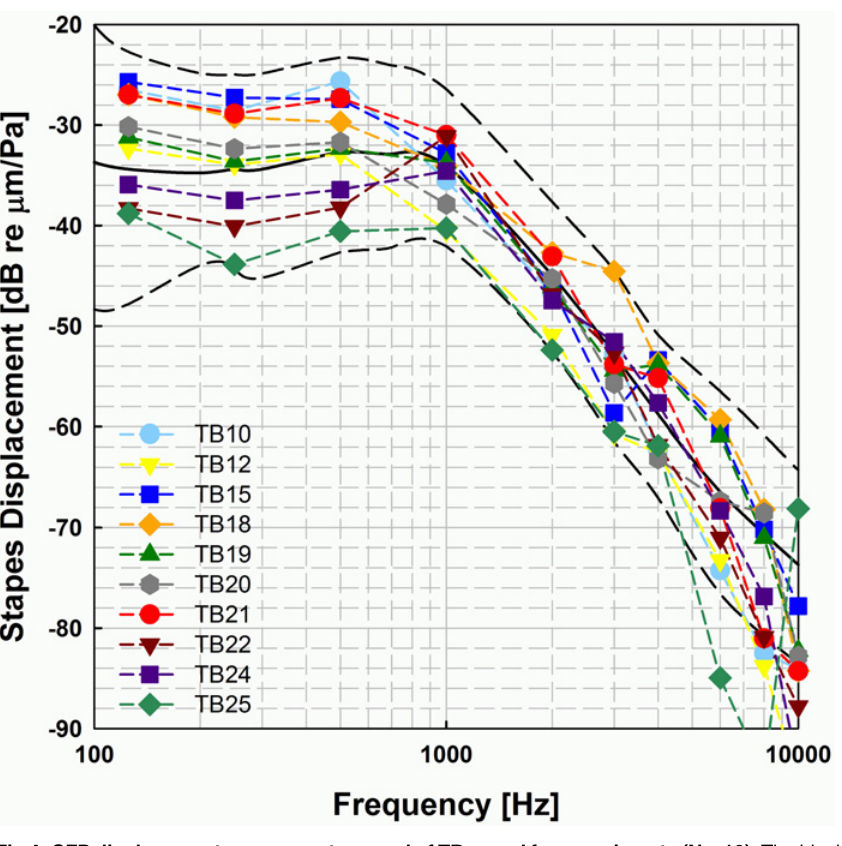
Fig 4. SFP displacement responses to sound of TBs used for experiments (N = 10). The black dashed lines depict the limits given by Rosowski et al. [11].